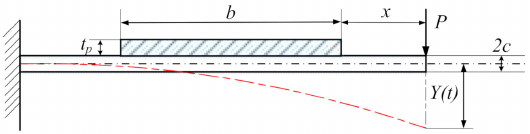
Figure 5. Deformation diagram of piezoelectric cantilever